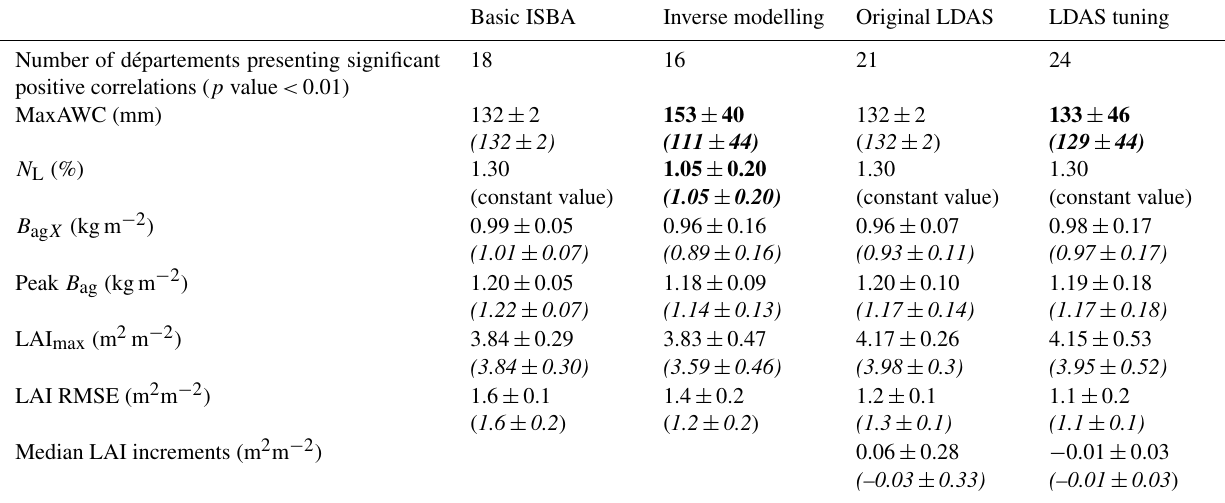
Table 1. Impact of the optimisation (either inverse modelling or LDAS tuning) on parameter values (spatial median values ± standard deviation) of the ISBA model (MaxAWC and N L ) , on the median value of B ag X and LAI max , on peak simulated B ag and on the models scores during the senescence period with respect to the disaggregated LAI observations. The results are given for the validated départements, i.e. those presenting a significant correlation ( p value < 0.01) of B ag X with Agreste straw cereal grain yield observations. Results for all 45 départements are given in brackets and in italics. Parameter values resulting from the optimisation are in bold. Because simulated LAI max and B ag X vary from one year to another, spatial median values are based on median temporal values across the considered 15-year period. Basic ISBA Inverse modelling Original LDAS LDAS tuning Number of départements presenting significant positive correlations ( p value < 0.01)